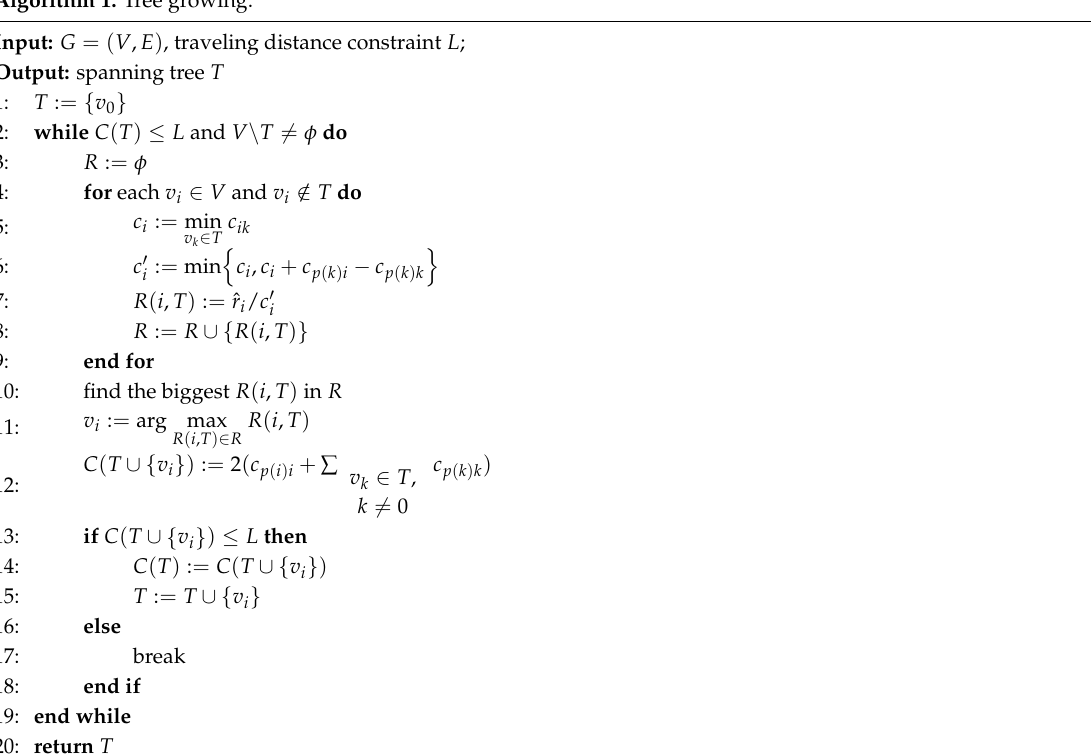
Algorithm 1. Tree